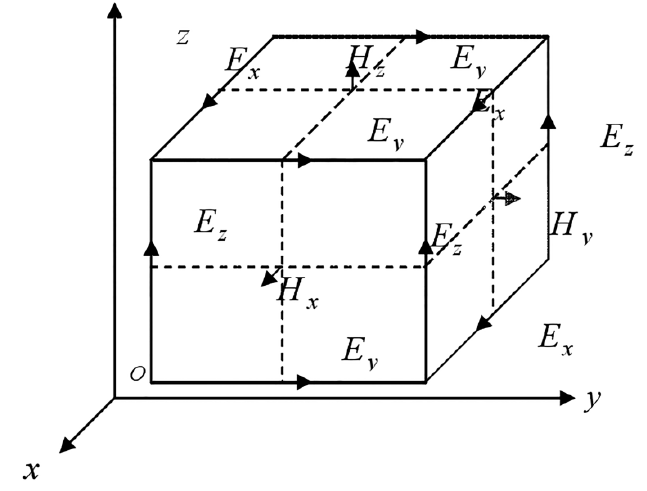
Figure 10. The Yee cells of electromagnetic field in FDTD simulations.